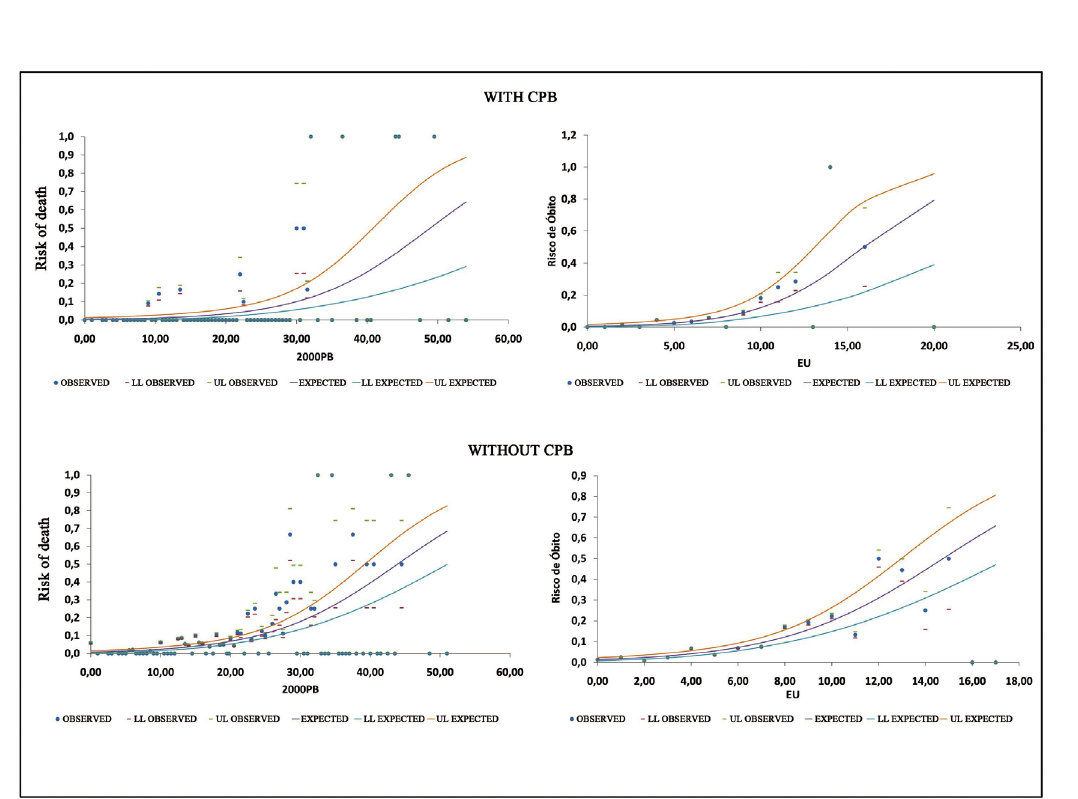
Fig. 3 - Observed and expected mortality by 2000 Bernstein Parsonnet (2000BP) and EuroSCORE (EU) for the groups with and without cardiopulmonary bypass for patients undergoing coronary artery bypass grafting